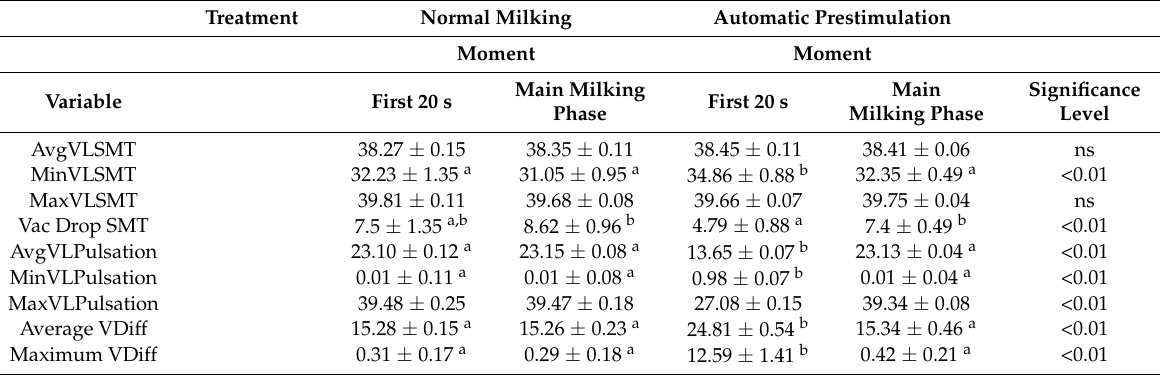
Table 3. Effect of the treatment (normal milking vs. milking with automatic prestimulation) during two moments of the milking (first 20 s and main milking phase) on variables related to vacuum level during the mechanical milking of Murciano-Granadina goats on the onset of lactation (least square means ± standard error of the